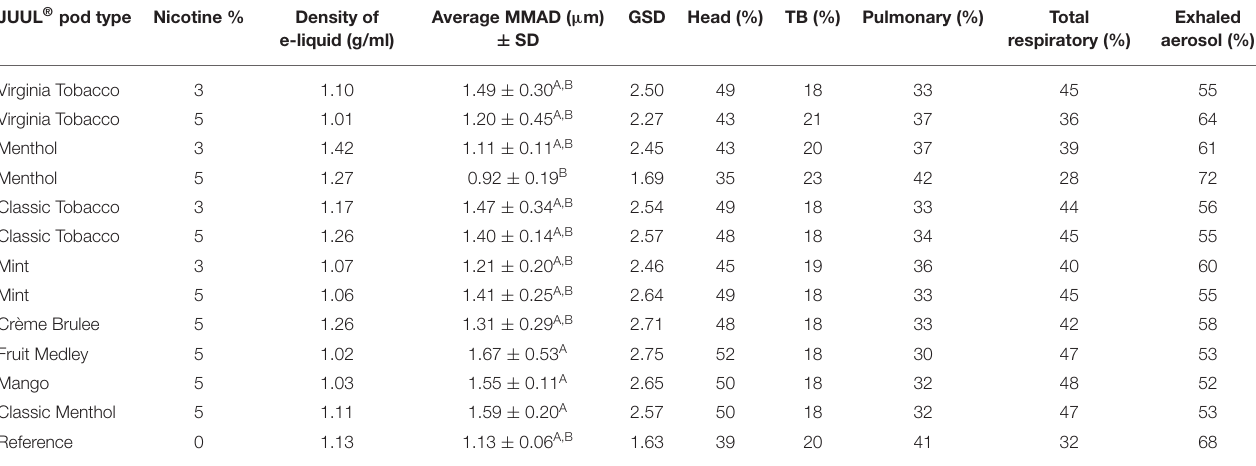
TABLE 3 | PSD, regional respiratory deposition, the percentage of exhaled electronic cigarette, or vaping, products (EVPs) aerosols, and statistical comparisons of JUUL ® pod types ( n = 5 puffs per pod type) and the reference e-liquid at the same puff profile (65-ml puff volume at 7.5W). JUUL ® pod type Nicotine